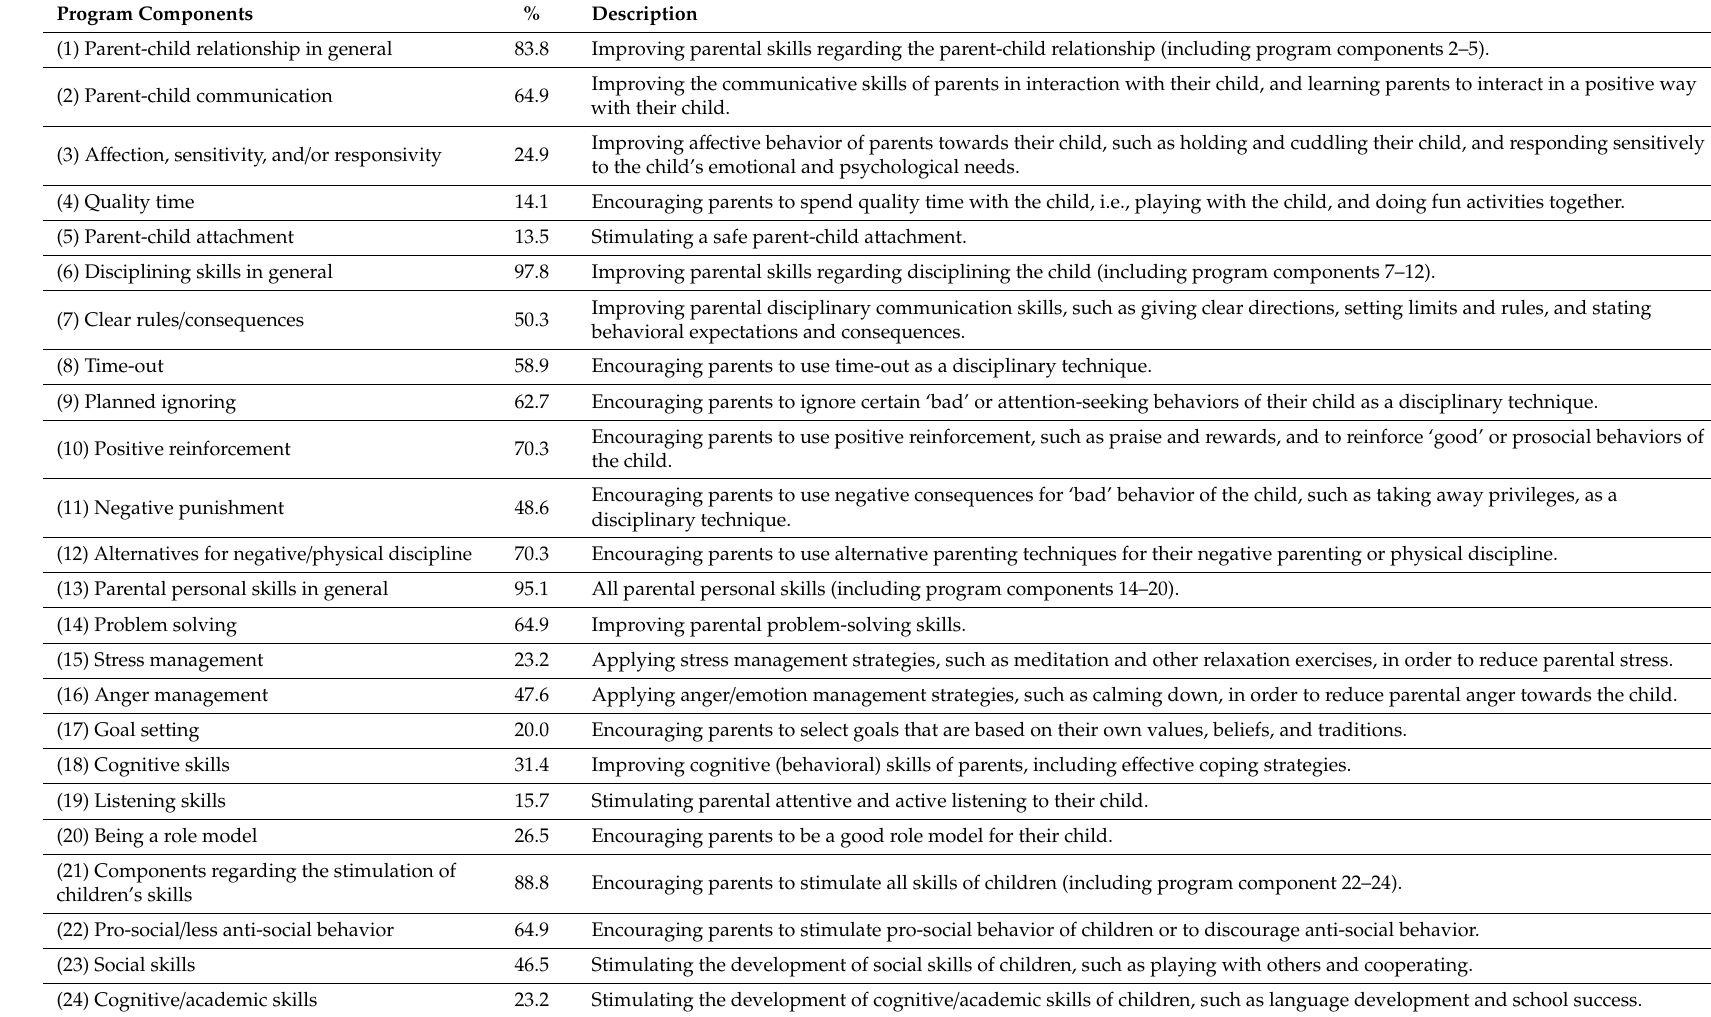
Table 1. Descriptions of the coded program components and delivery techniques and their